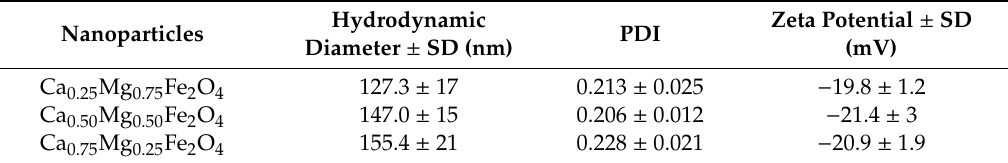
Table 6. Hydrodynamic size, polydispersity, and zeta potential of DPPC solid magnetoliposomes containing calcium-substituted magnesium ferrite nanoparticles (SD: standard deviation; PDI: polydispersity index).